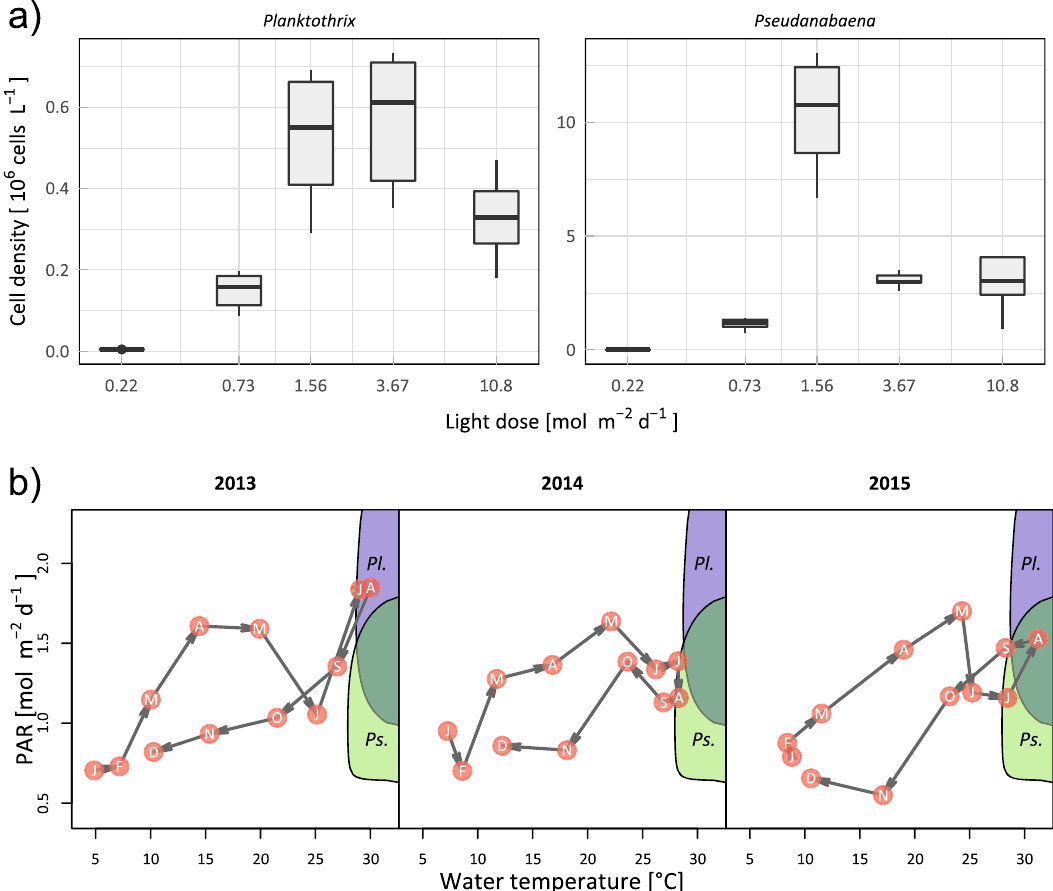
Fig. 5 Growth of Planktothrix and Pseudanabaena under culture conditions including 5 levels of light doses. a and fi eld environment of QCS Reservoir from 2013 to 2015. b Growth yield of Planktothrix and Pseudanabaena within stationary phase (day 15 – 35) was used. Source data of Planktothrix growth is from 34 . Boxplot is Tukey style, where the bottom and top of the boxes denote the 25% and 75% quantiles, the ends of whiskers represent minimum and maximum cell densities with outliers removed, and the bands in the boxes denote the median cell densities. The zones colored purple and green denote the 90% quantile niche spaces (water temperature & pre-week PAR) of Planktothrix and Pseudanabaena , respectively. The red circles with a letter inside (J – D = January – December) denote the environmental conditions (represented by mean water temperature and mean pre-week PAR) in the corresponding